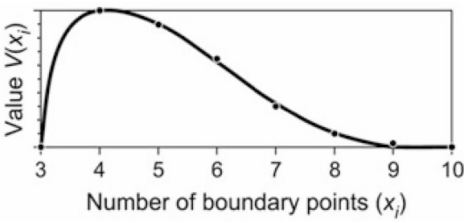
Figure 11. Graph of number of boundary points value function